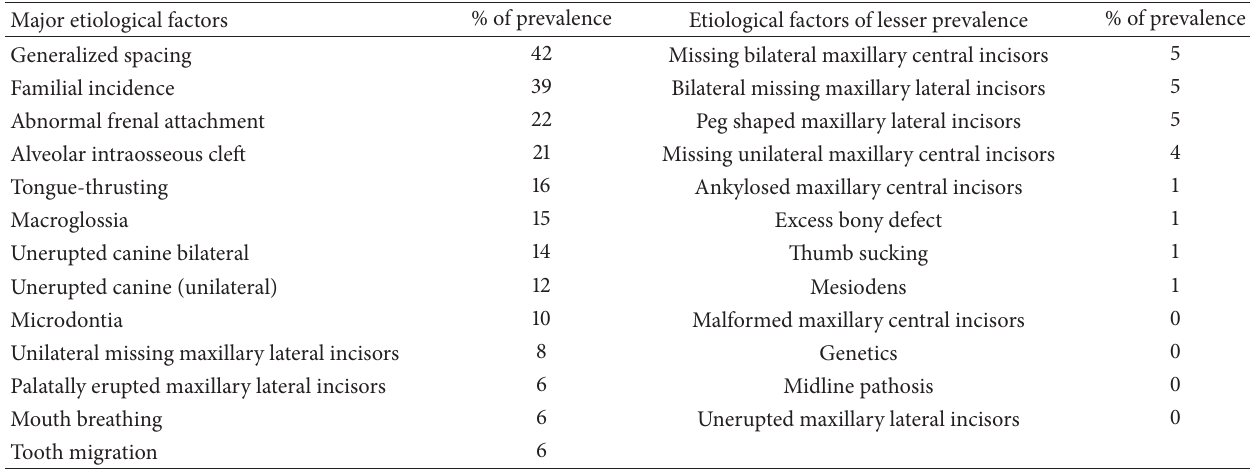
Table 1: The etiological factors of the maxillary midline diastema extracted from the